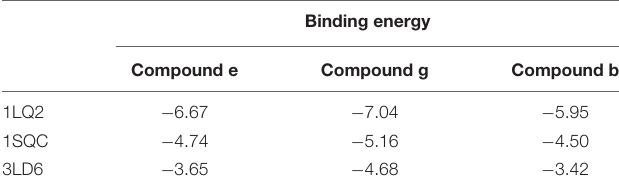
in sterile culture tubes. MCZ, TBF, and compounds e and g were then added to the solution to achieve drug concentrations at 1/2MIC, MIC, and 2MIC and total volumes in each culture tube to 1.8 mL. The tubes were then incubated at 35 ◦ C with continuous agitation (200 rpm) for 0, 2, 4, 8, 12, 24, 48, 72, and 96 h. The second part was removed from each solution and serially diluted in sterile ddH 2 O. Each dilution was then spread onto PDA plates and incubated at 35 ◦ C. Colonies were then enumerated after 24–48 h of incubation. The experiments were performed in